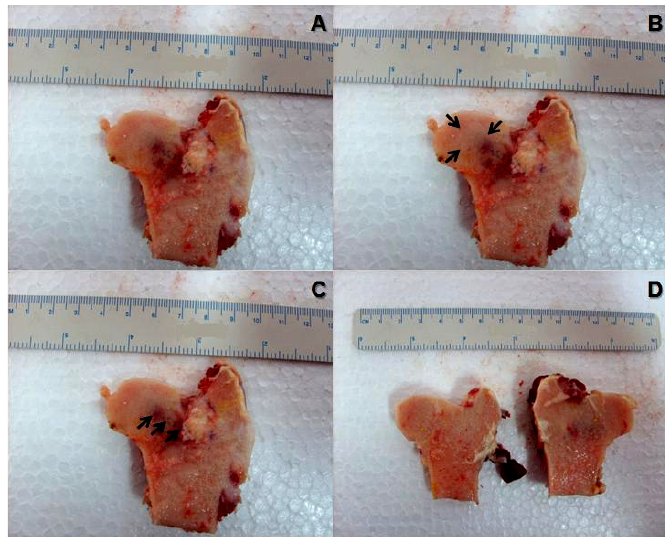
FIGURE 2 – Macroscopic aspects of femoral head and column of ovine submitted to osteonecrosis of the femoral head and stem cell therapy. A. Image of the femoral head of a sheep submitted to induction of osteonecrosis of the femoral head (ONFH). B. The arrows delineate the area of bone collapse visible in (A). C. The arrows point to the passage of the cannula drill, from the great trochanter to the center of the femoral head. D. Femoral head of the contralateral member of the same animal.